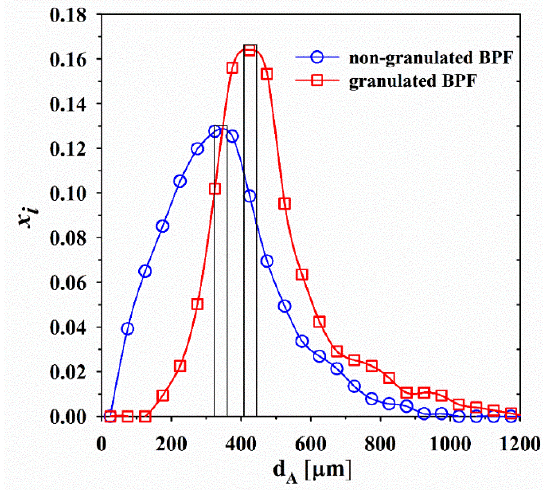
Figure 1. Fractional particle size distribution of BPF before and after wet fluidized bed granulation with 5% w / v of lactose solution containing LAB at a pilot-scale level.